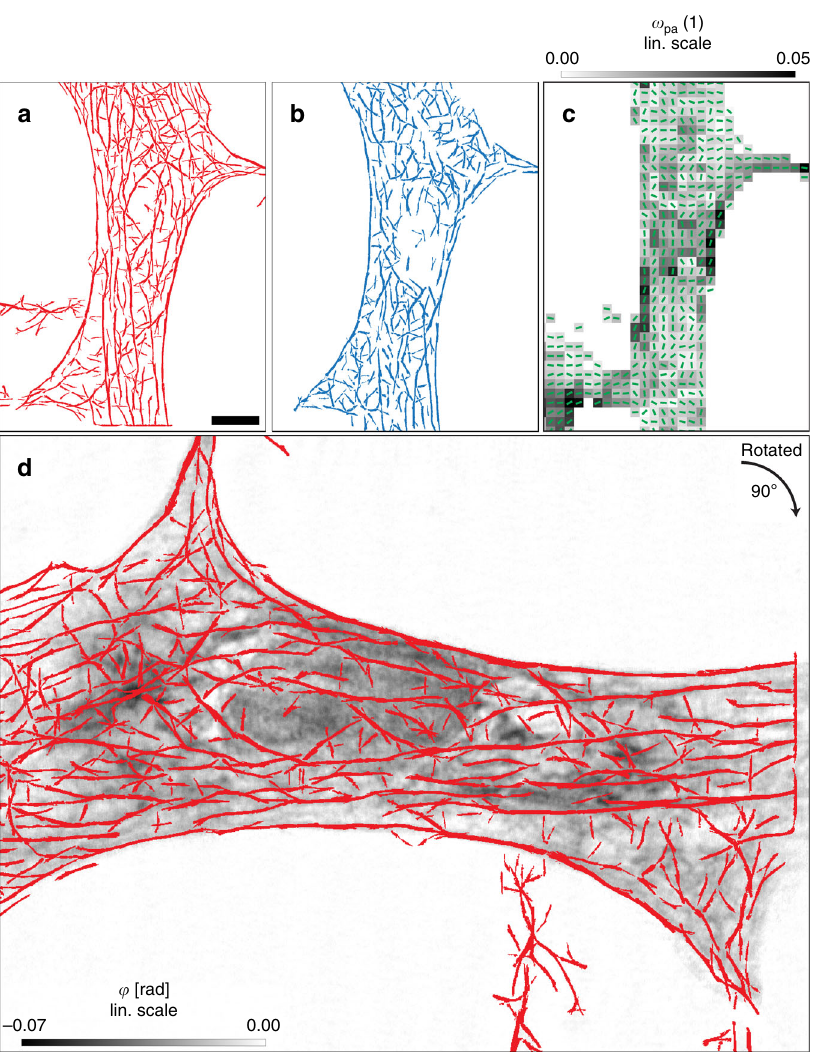
Fig. 3 Filament analysis of all three contrast schemes. a Actin fi laments detected in the STED micrograph by a fi lament sensor algorithm (red). Scale bar: 5 μ m. b Filaments detected in the X-ray phase map (X-ray holography), using the same fi lament sensor algorithm (blue). c Analysis of the SAXS signal, yielding the anisotropy parameter ω (gray scale), which quanti fi es the degree of anisotropy of the diffraction patterns, as well as the direction of the principal scattering axis θ (lines correspond to long axis in real space), as obtained by PCA analysis of the diffraction pattern. Both ω and θ are thresholded to X-ray dark fi eld values above I df = 7.5 ⋅ 10 5 ph./s. d Superposition of STED fi laments (red) and the phase map (gray scale) of the holographic reconstruction. The reconstructed phase is proportional to the projected electron